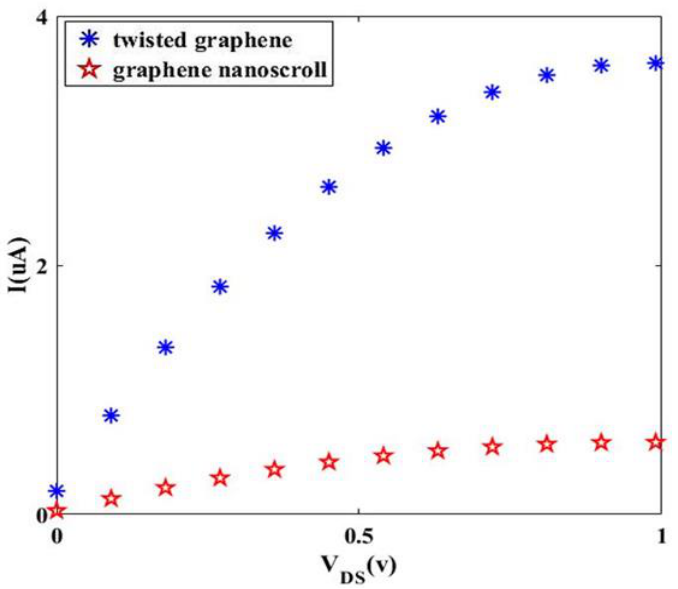
Figure 12. Comparison of the I-V characteristic of our proposed transistor and graphene nanoscroll- based Schottky transistor in the same channel length of 60